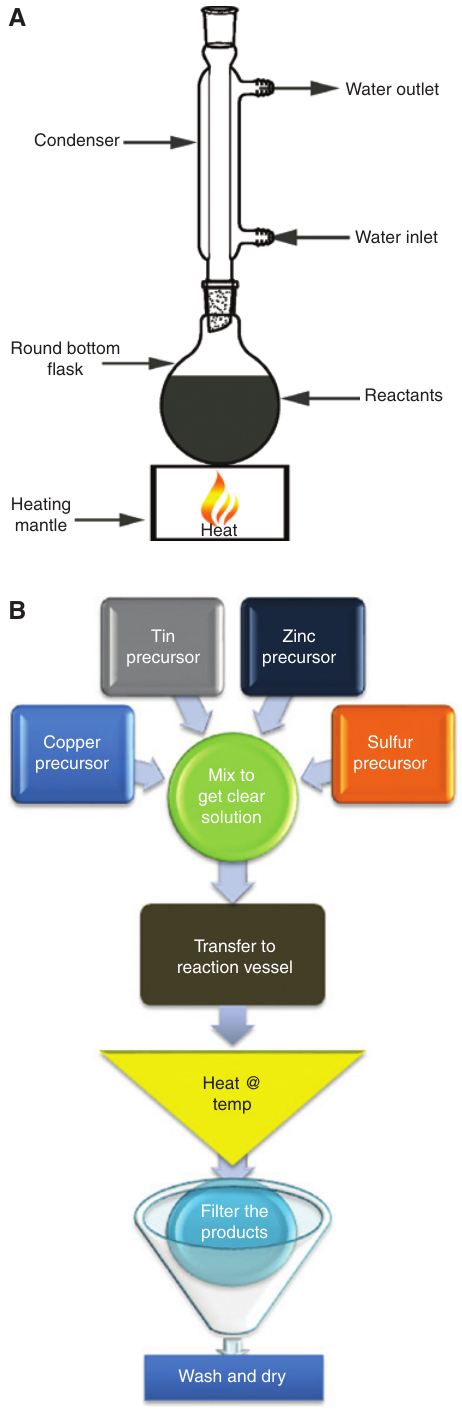
Figure 1: (A) Schematic of the reflux setup and (B) flow chart of reaction sequence of CZTS